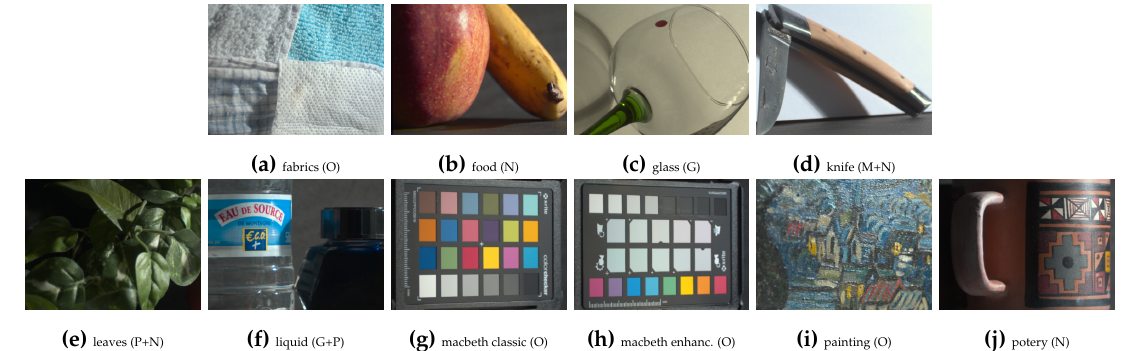
Figure 3. Visualization of the 10 scenes of the data from Lapray et al. [32] by alphabetical order. The material clustering for each scene is represented by the acronym: M (Metallic), N (Natural), A (Active), P (Plastic), G (Glass), and O